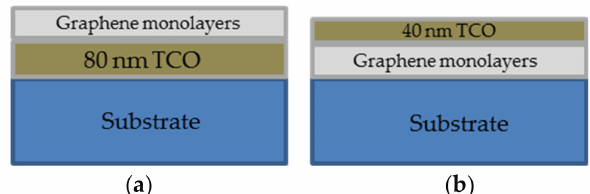
Figure 1. TCE configurations under study ( a ) configuration 1, and ( b ) configuration